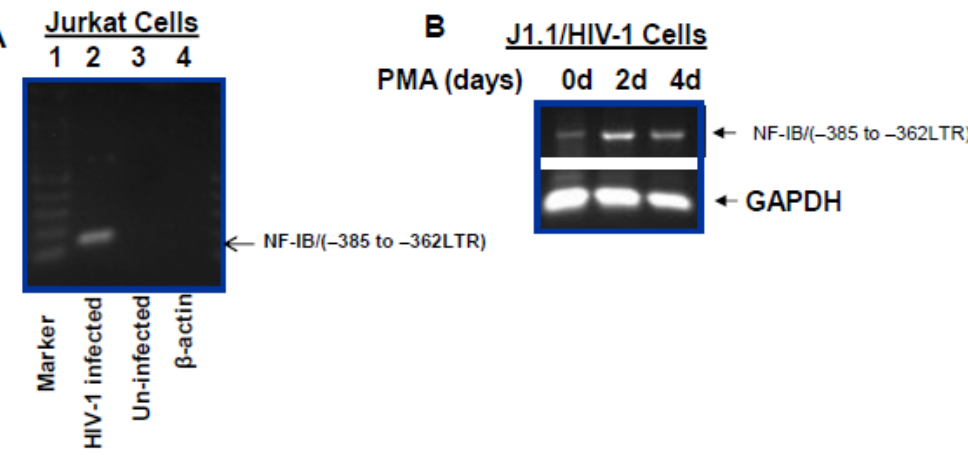
Figure 5. Association of NF-IB with the HIV-1 LTR. Chip assay was performed to see the in vivo association of NF-IB with the LTR in control and HIV-1 infected Jurkat cells ( A ); lane 1, 100 bp DNA marker; lane 2, samples from NF-IB antibody pull-down (HIV-1 infected); lane 3, samples from NF-IB antibody pull-down (Un-infected); lane 4,